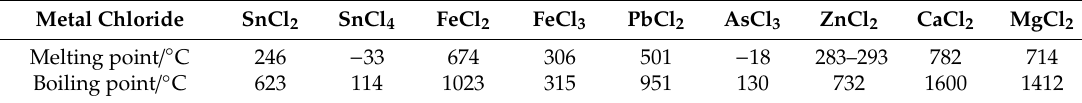
Table 2. The melting and boiling points of some metal